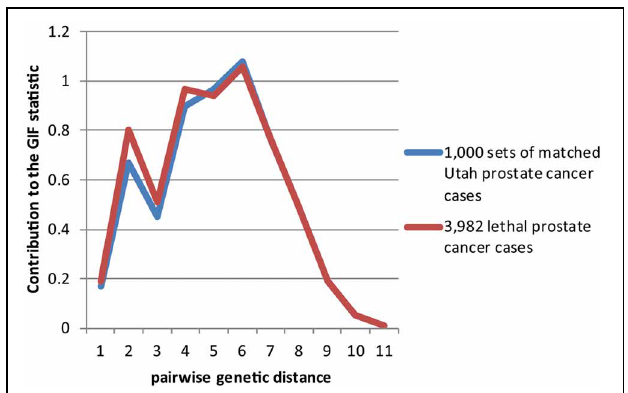
FIGURE 4 | Contribution to the GIF statistic by pairwise genetic distance for cases and controls for prostate cancer cases that have prostate cancer as a cause of death.